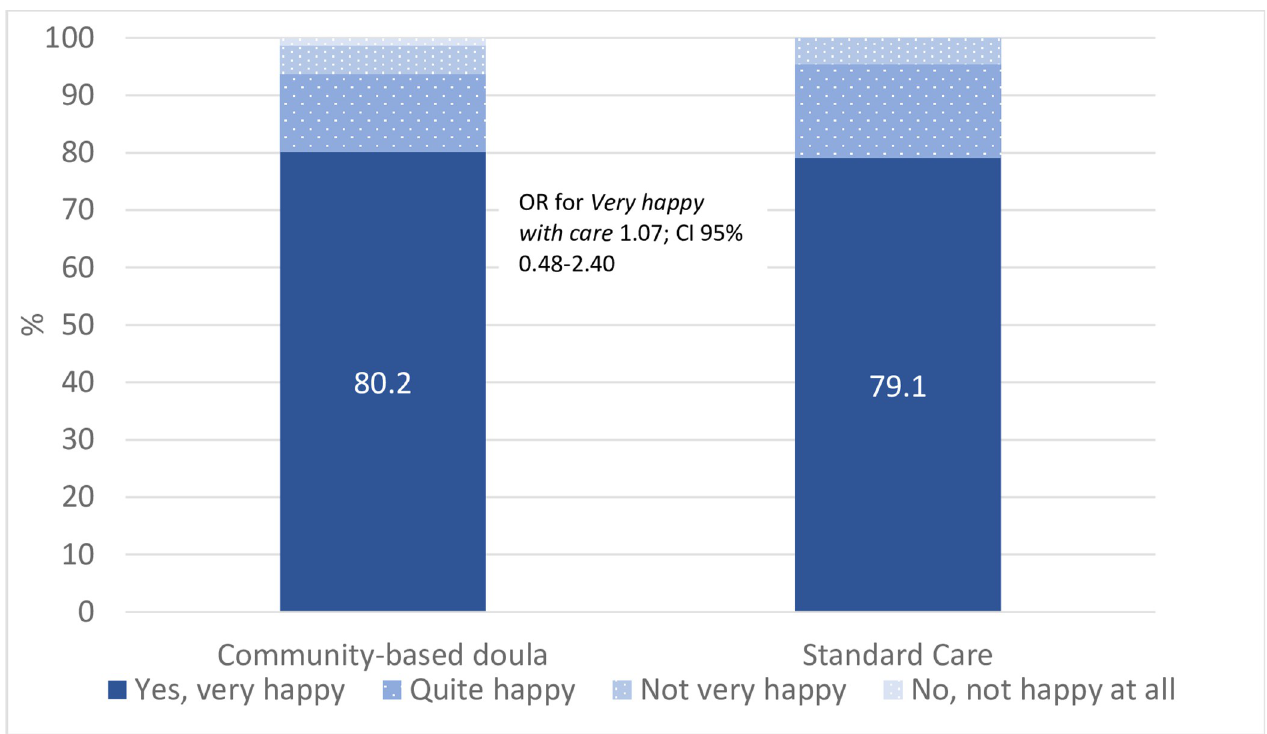
Fig 2. Overall ratings of care in women with community based doula support and women with standard care.